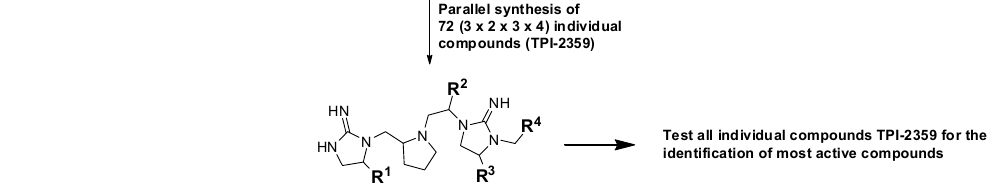
Figure 2. Deconvolution of positional scanning pyrrolidine bis ‐ cyclic guanidine library TPI ‐ 1955 and synthesis of individual compounds TPI ‐ 2359.